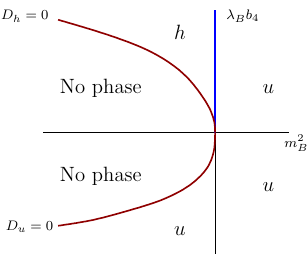
Figure 11 . Phase diagram for x 6 < (cid:30) 1 . The positive (cid:21) B b 4 axis (shown in blue) corresponds to a second-order phase